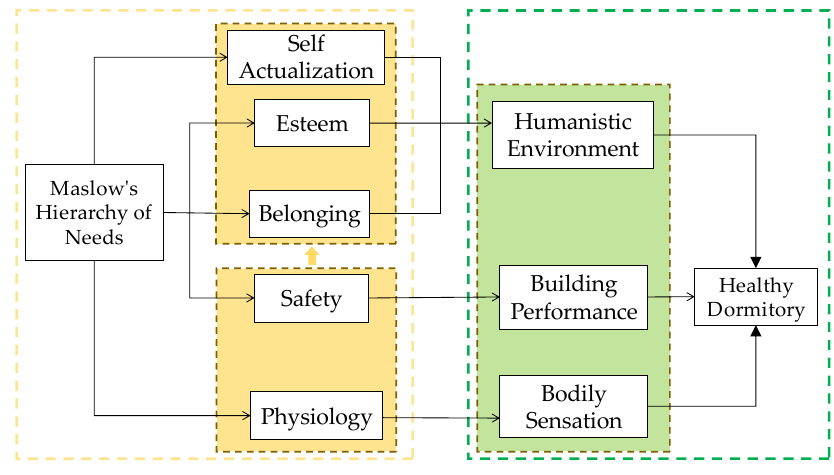
Figure 1. Definition framework of healthy dormitory.